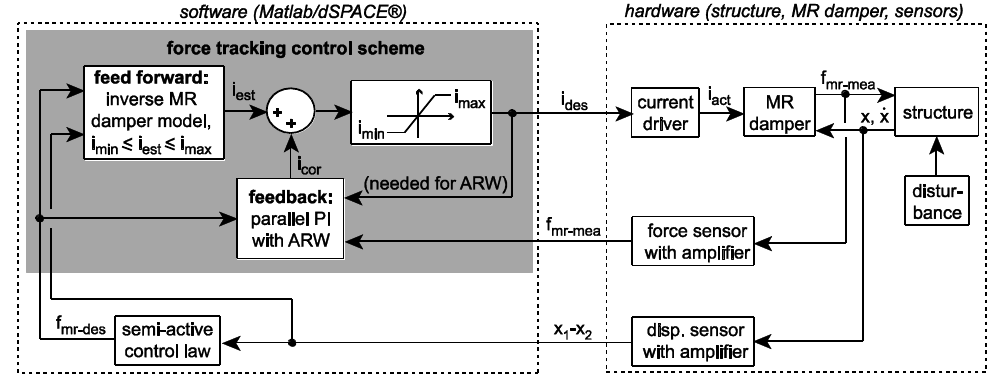
Figure 11. Force tracking control by model-based feed forward and linear feedback with anti-reset windup.